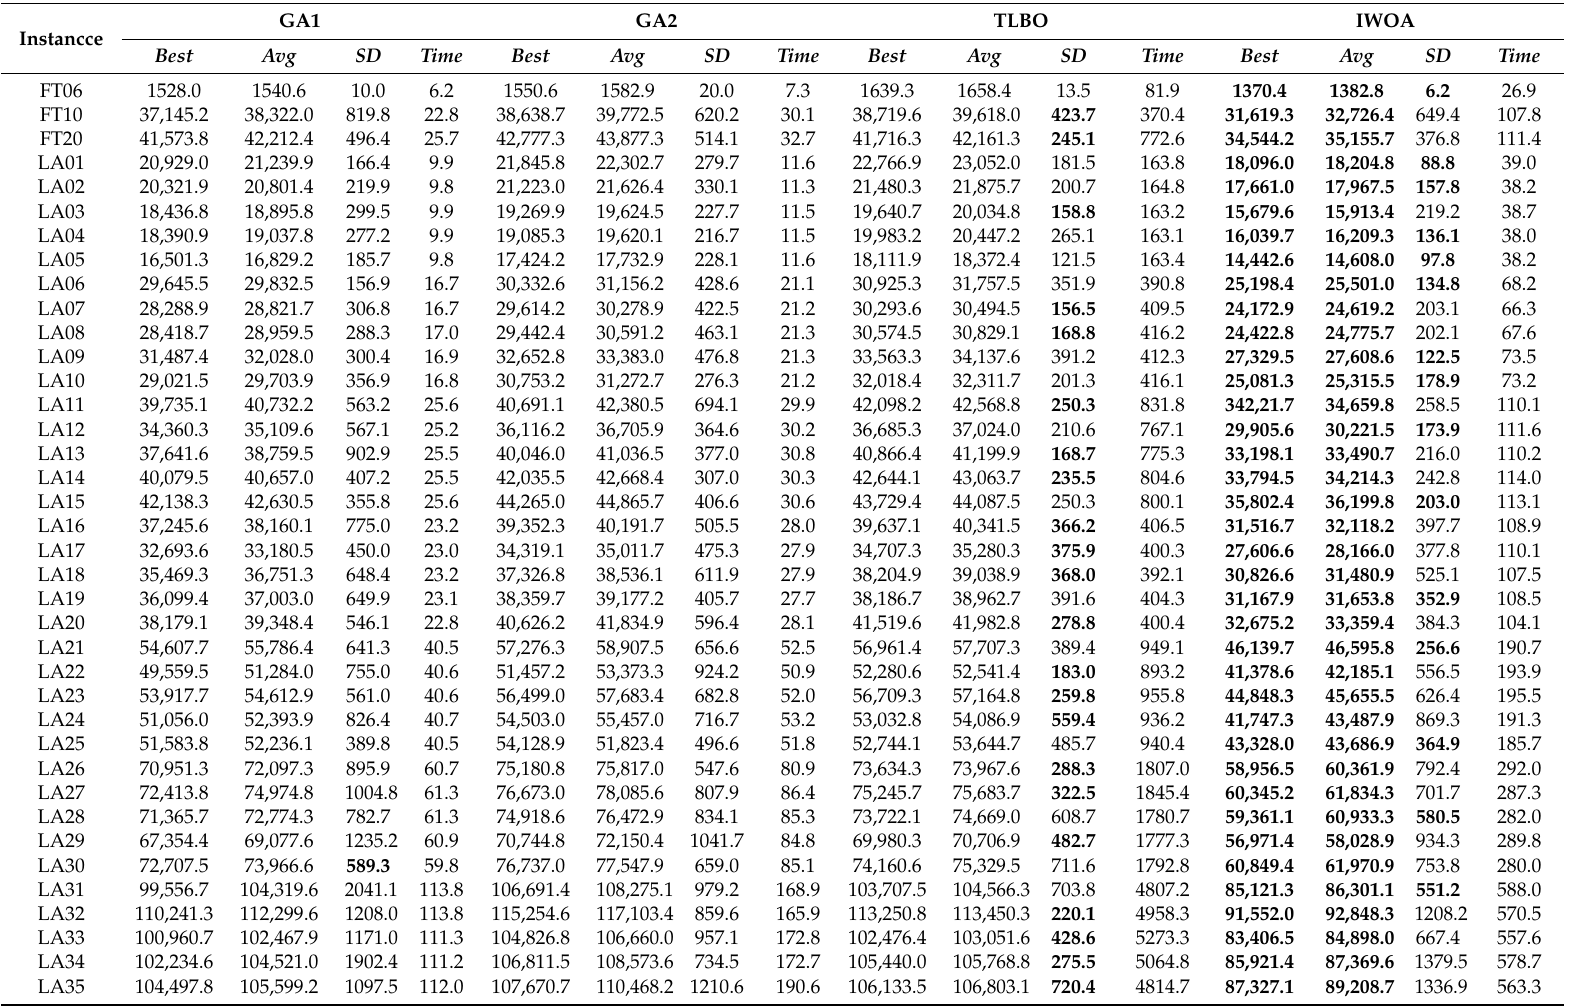
Table 2. Comparison between different